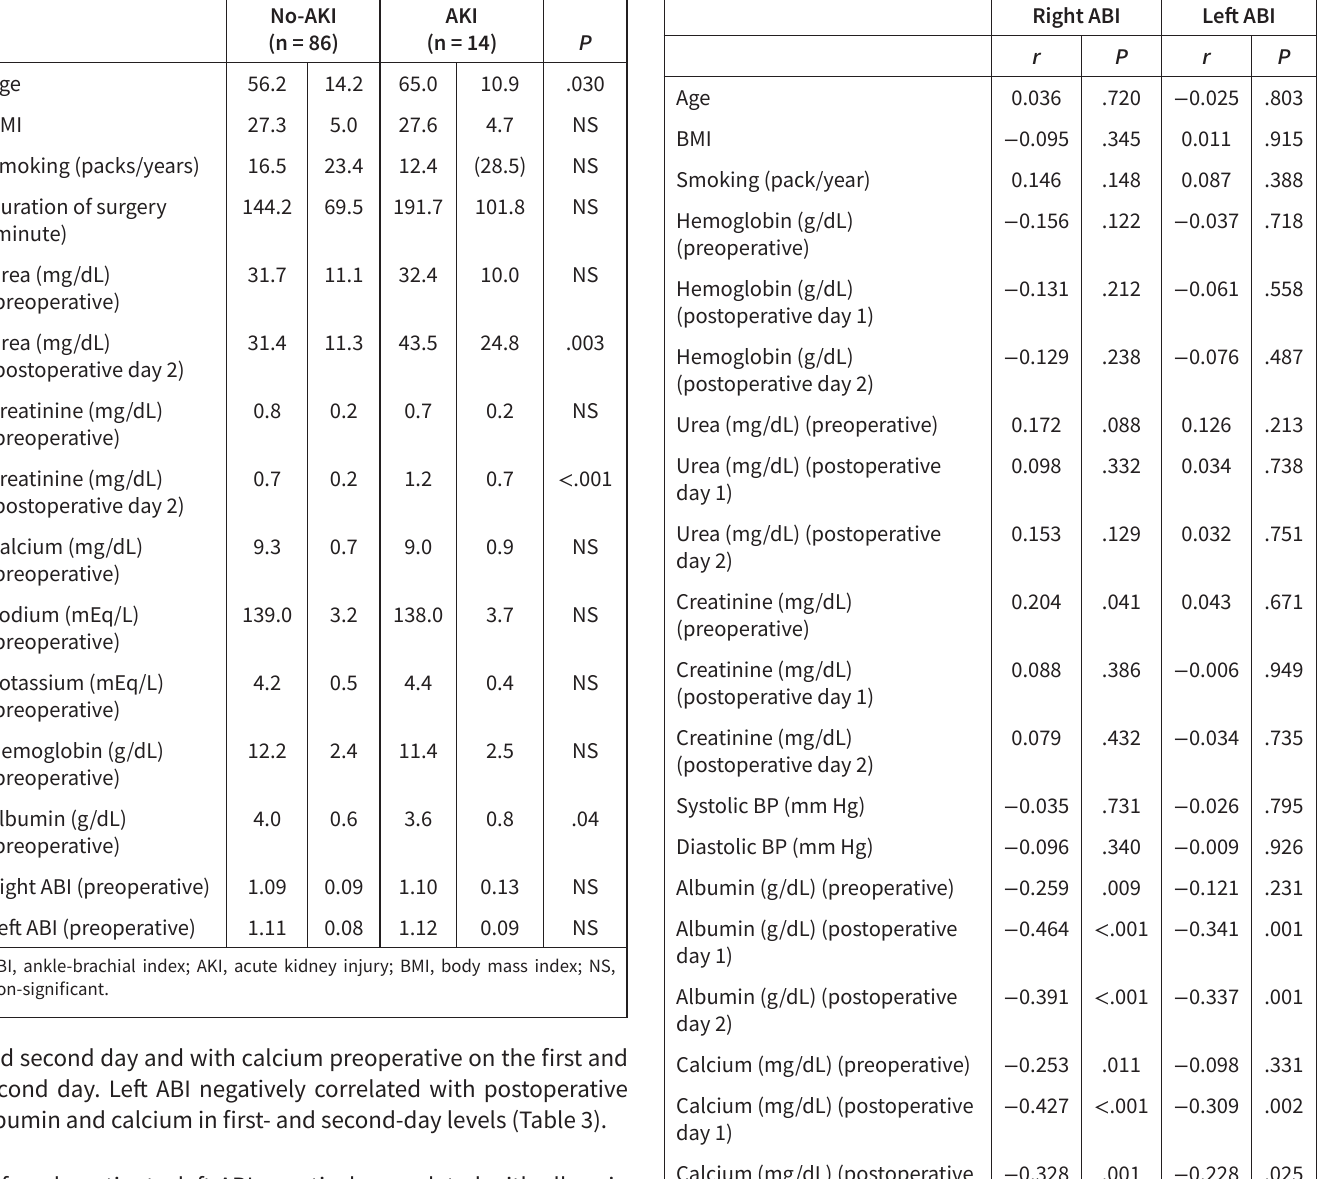
Table 3. Relationship Between ABI and Clinical Features and Baseline Laboratory Parameters